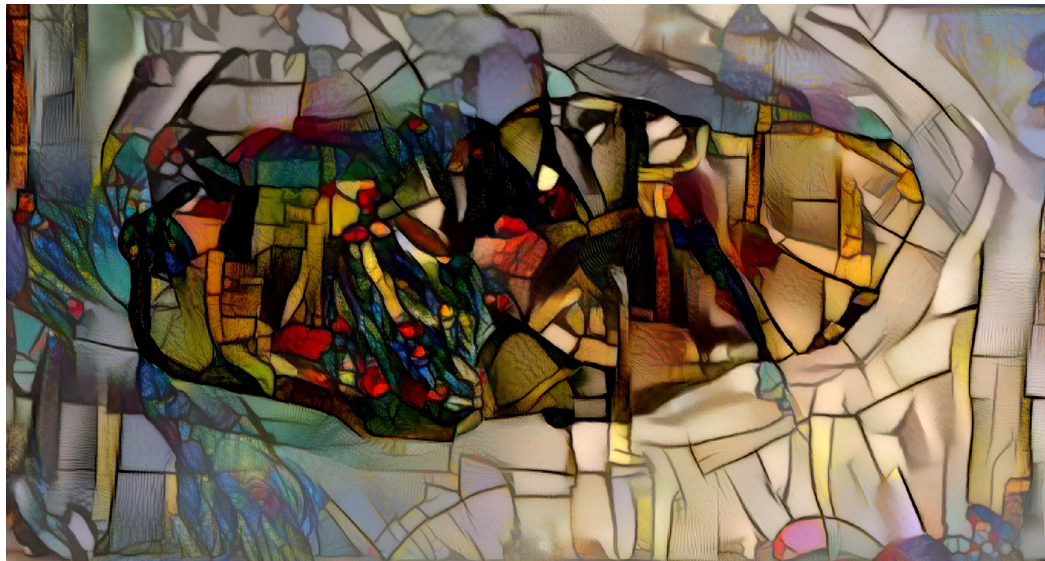
Figure 8: #FlintFriday – Silica Alchemy IV,